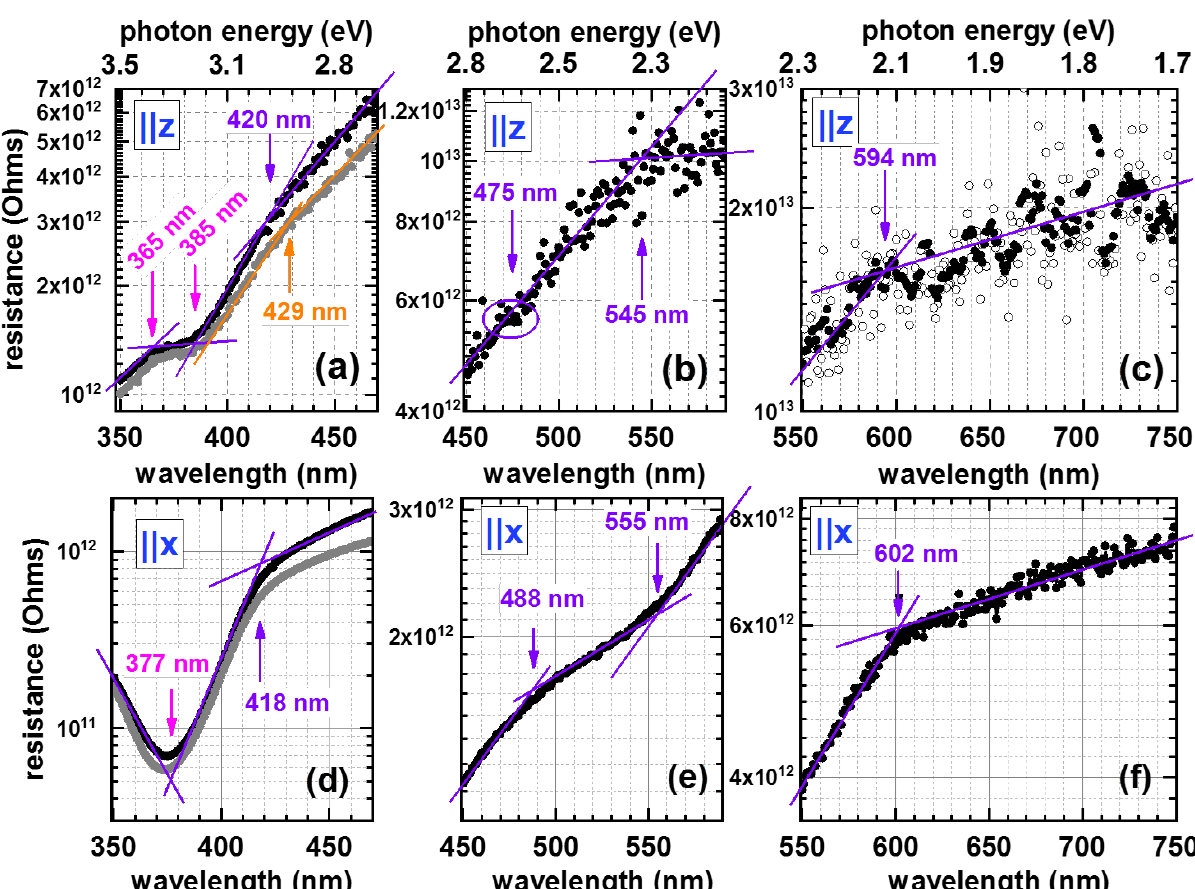
Figure 2. Comparative semilogarithmic resistance plots with spectral features: While subfigures ( a – c ) show the wavelength dependence of the resistance measured along the polar axis (z-cut sample), the subfigures ( d – f ) depict the corresponding data recorded for the x-cut sample. The data was acquired within three overlapping partial spectra beginning at the high-wavelength end in all cases. Points of slope change or discontinuities in the from of small plateaus are indicated by arrows and are summarized in Table 2. For the subspectra ( a , d ) the two different curves (black vs. grey) demonstrate the degree of reproducibility; for case ( c ) a smoothed curve (filled circles) is shown alongside with the quite scattering original data (open circles). The extracted spectral features were compared with those extracted from the corresponding linear plots, which can be found in Figure